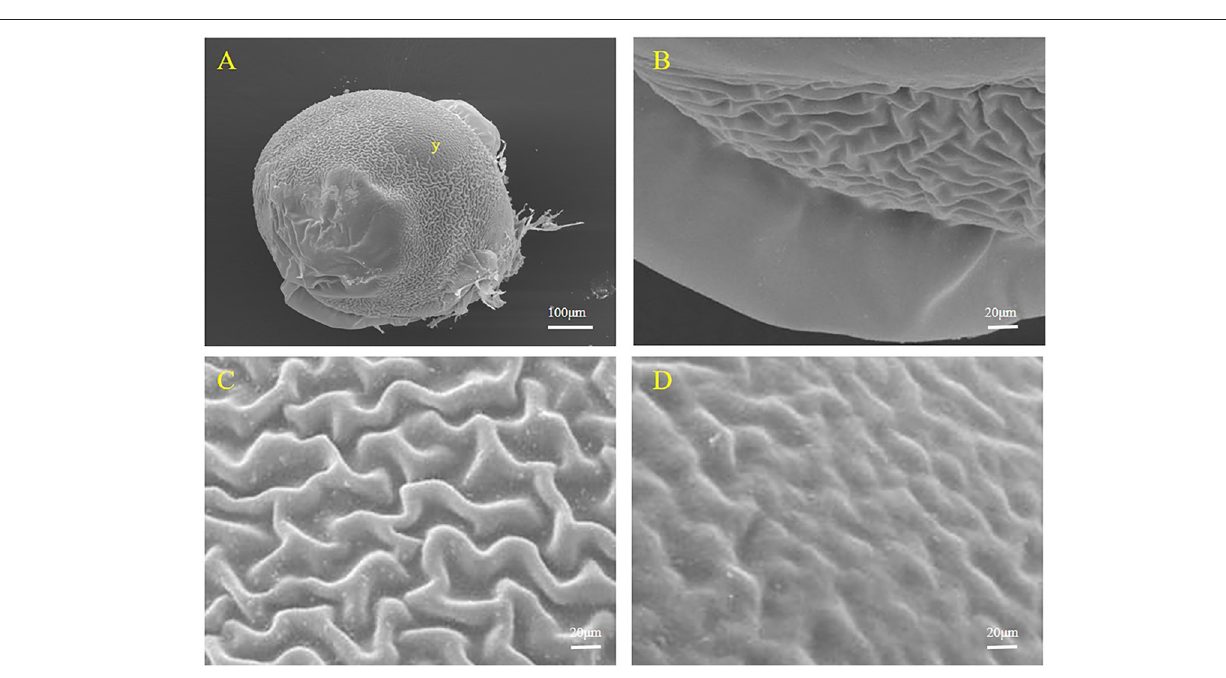
composed of phase III oocytes and early oocytes ( Figures 7B–D ). At this time, the oocytes are nearly round, the cytoplasm is weakly basophilic, and the oocytes begin to accumulate nutrients.